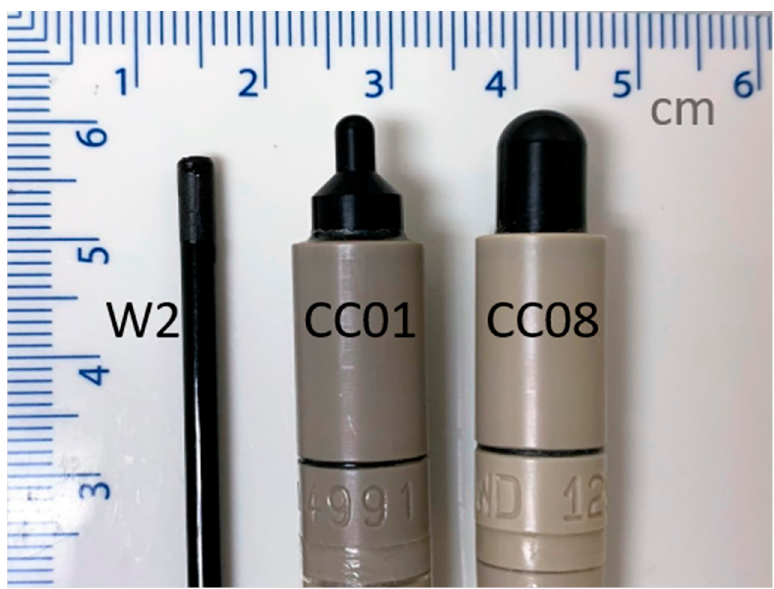
Figure 1. Exadrin W2 Scintillator from Standard Imaging ( left ) and the IBA Dosimetry CC01 ( center ) and CC08 ( right ) ion chambers.